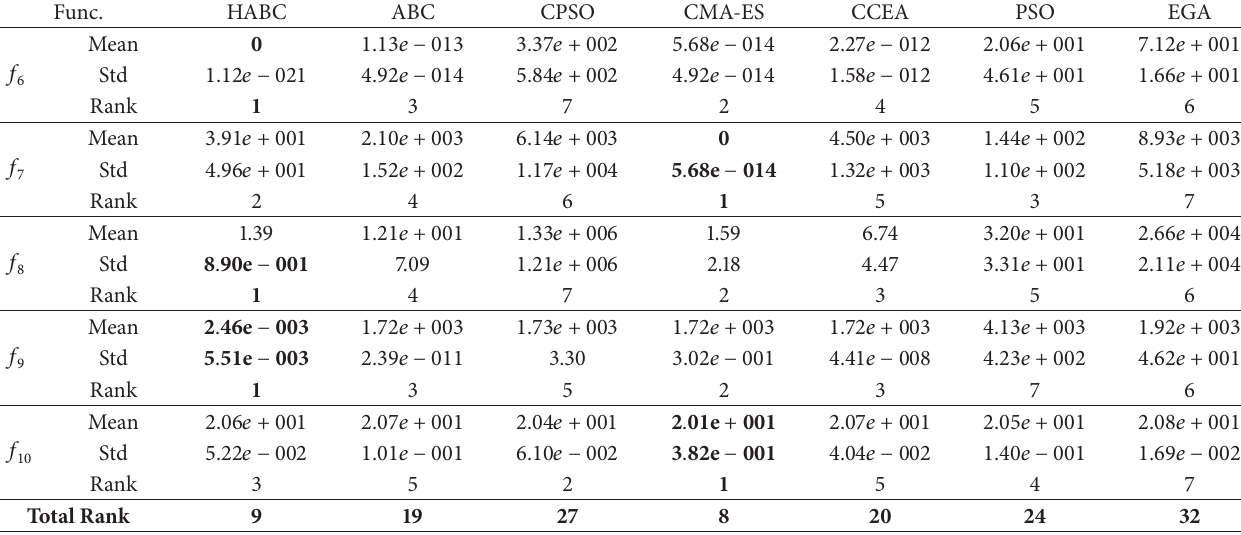
Table 4: Performance of all algorithms on 100 𝐷 benchmark functions 𝑓 6 – 𝑓 10 . In bold are the best results. Func.